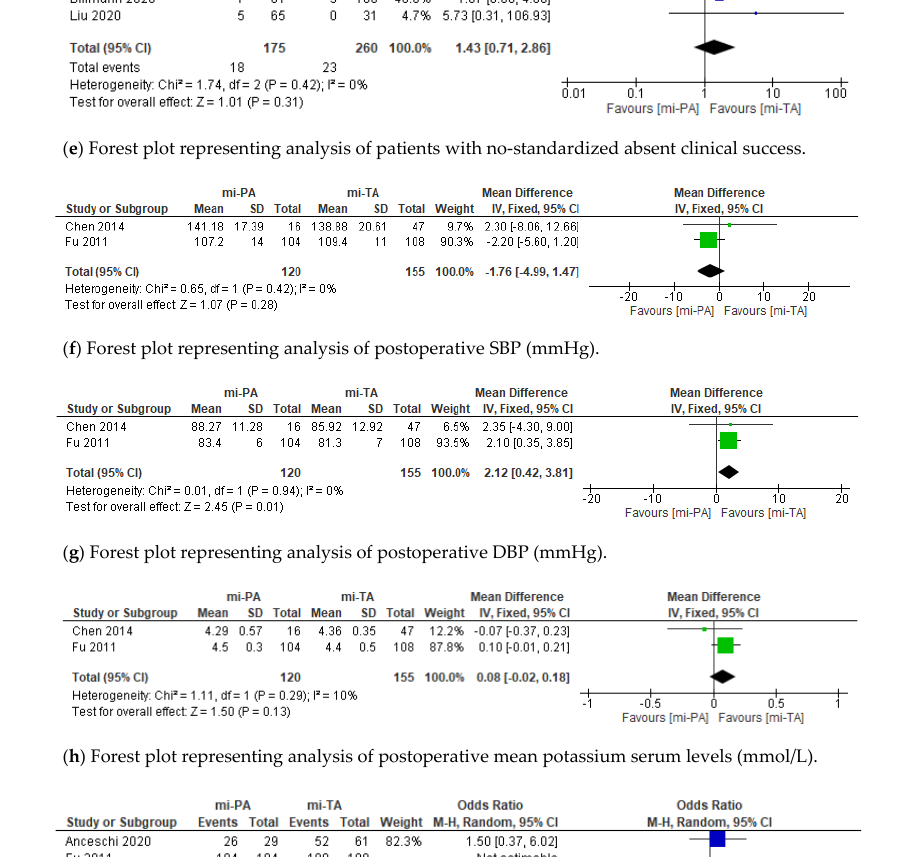
is represented by a square incorporating confidence intervals represented by horizontal lines. The